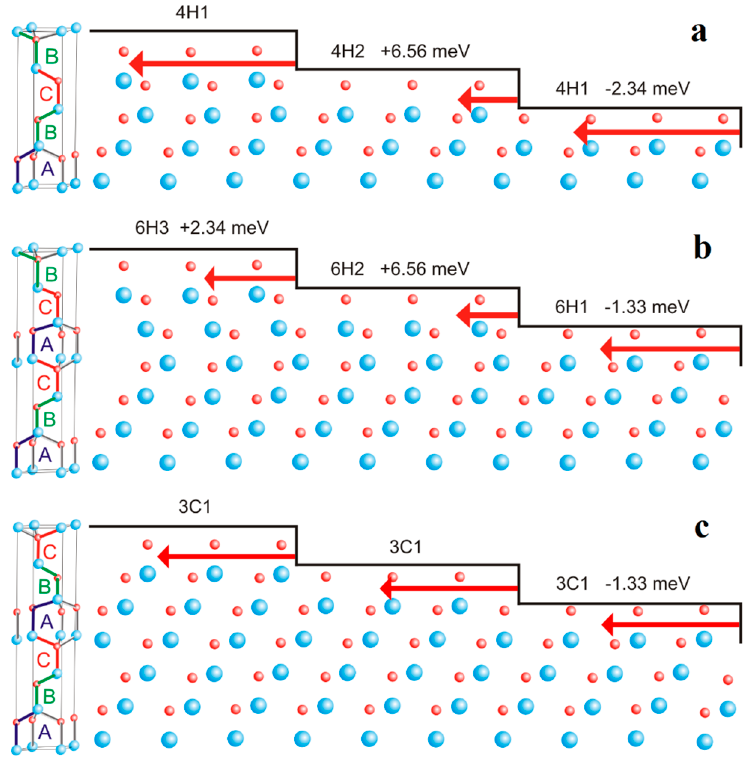
Figure 14. Stacking sequences and possible terraces on ( a ) 4H-SiC, ( b ) 6H-SiC, and ( c ) 3C-SiC surfaces. Large (blue) and small (red) circles represent Si and C atoms, respectively. Length of arrows indicates different step decomposition velocities. The surface energies needed to remove a particular terrace are demarcated [22].